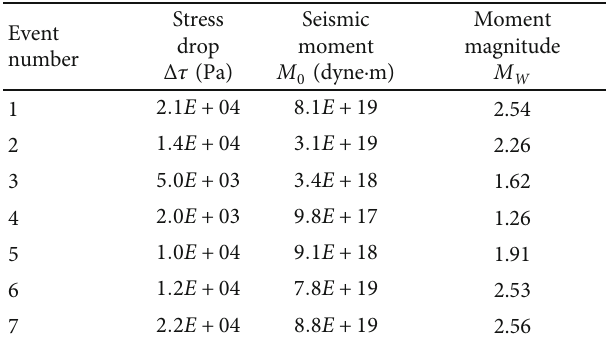
Figure 6: Overview picture of the Strathcona mine (captured from MinDat: https://www.mindat.org/). Table 2: The source parameters of the seven mining-induced events of the Strathcona mine.